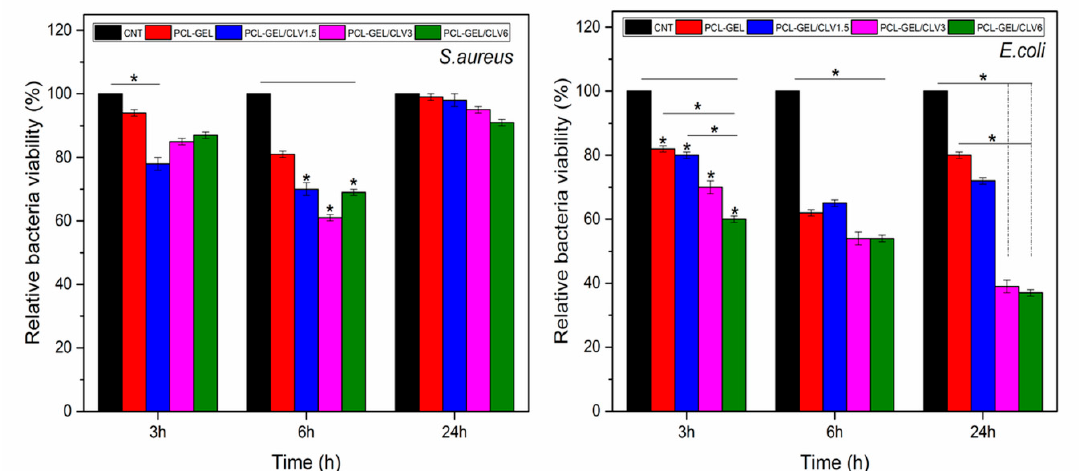
Figure 4. Antibacterial activity of PCL-GEL and CLV-loaded PCL-GEL nanofiber mats after 3, 6, and 24 h incubation with S. aureus (Gram-positive) and E. coli (Gram-negative) bacteria ( n = 3, samples in triplicate,* p < 0.05).